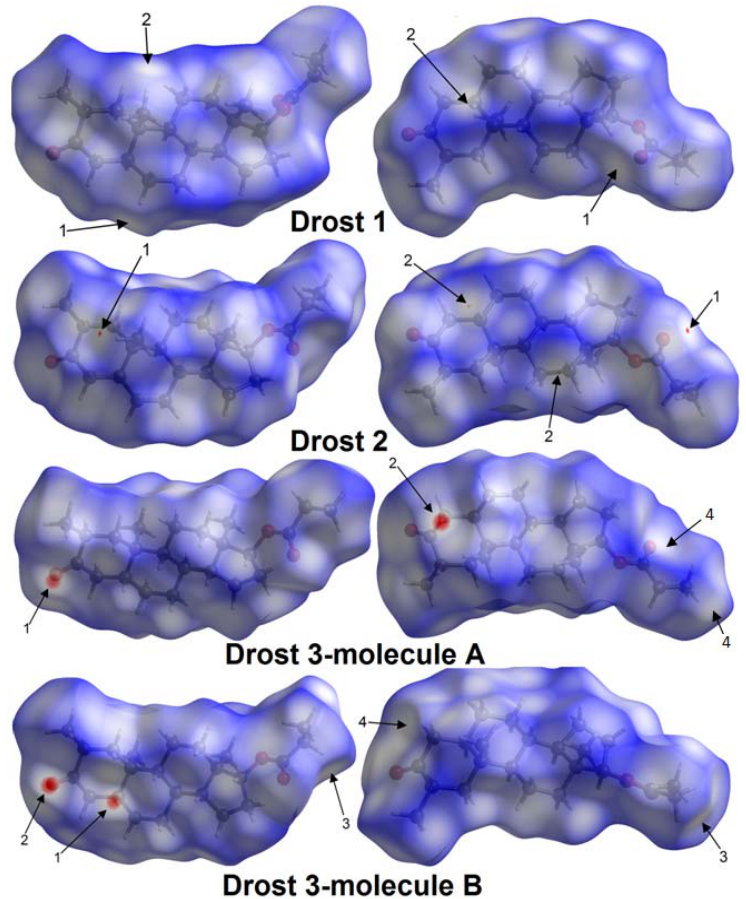
Figure 7. Hirshfeld surfaces showing the interactions shorter than van der Waals radii with the contacts referred to Table 3. The color scale for the d norm property mapped on the Hirshfeld surface is in the range of 0.013 (white) to 1.563 (blue) for Drost 1, − 0.016 (red) to 1.444 (blue) for Drost 2, − 0.151 (red) to 1.628 (blue) for Drost 3.